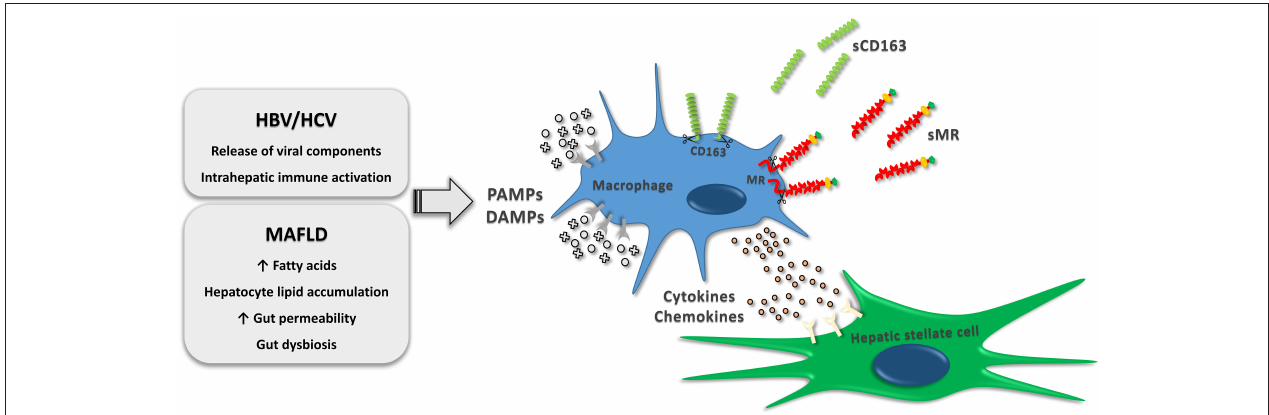
FIGURE 1 | Macrophage activation by immunomodulatory events occurring in MAFLD and chronic HBV or HCV infections. The activation increase receptor shedding, which results in release of soluble CD163 and soluble MR to the circulation. Furthermore, cytokines and chemokines released by resident and recruited liver macrophages stimulate hepatic stellate cell differentiation into myofibroblasts consequently causing synthesis of extracellular matrix components. HBV, hepatitis B virus; HCV, hepatitis C virus; MAFLD, metabolic associated fatty liver disease; PAMPs, pathogen-associated molecular patterns; DAMPs, damage-associated molecular patterns; sCD163, soluble cluster of differentiation 163; sMR, soluble mannose